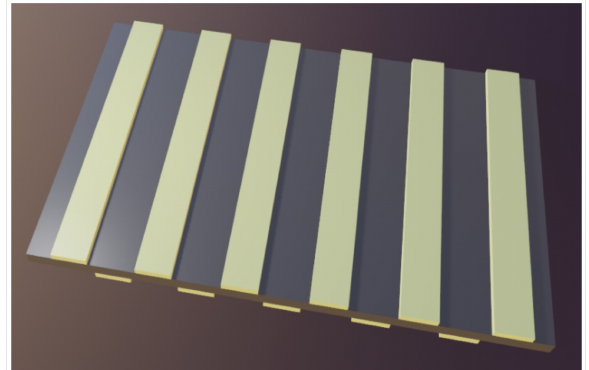
Figure 8. Freestanding dual plasmonic waveguide with two arrays of golden nanostrips, one on the top surface of the dielectric (silica) nanomembrane and the other on the bottom, laterally shifted to each other. The thickness of gold nanostrips is 10 nm, their width 450 nm, while the thickness of freestanding silica is 20 nm and the lateral shift between two successive nanostrips is 550